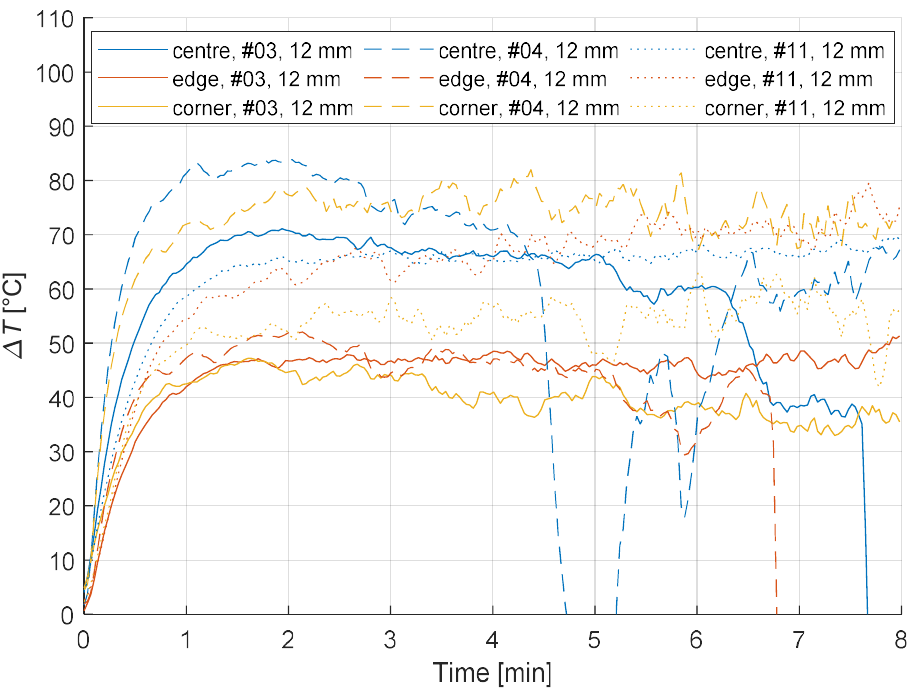
Figure 8. Through-the-thickness temperature differences at various locations (centre/edge/corner) for 12 mm specimens (Test #3, #4 and #11). Note the connection problems for centre TC (1) in test #4.